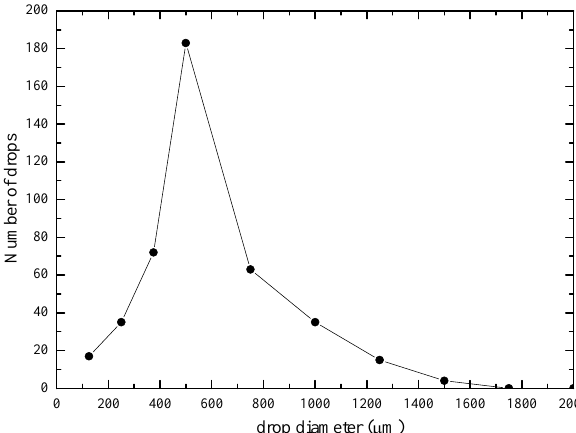
Figure 14. Precipitating particle size distribution as obtained from the time series of the dis- 844 Fig. 14. Precipitating particle size distribution as obtained from the drometer measurements at ground level in Besenfeld (27 km East of Supersite R). 845 time series of the disdrometer measurements at ground level in Be- 846 senfeld (27km East of Supersite